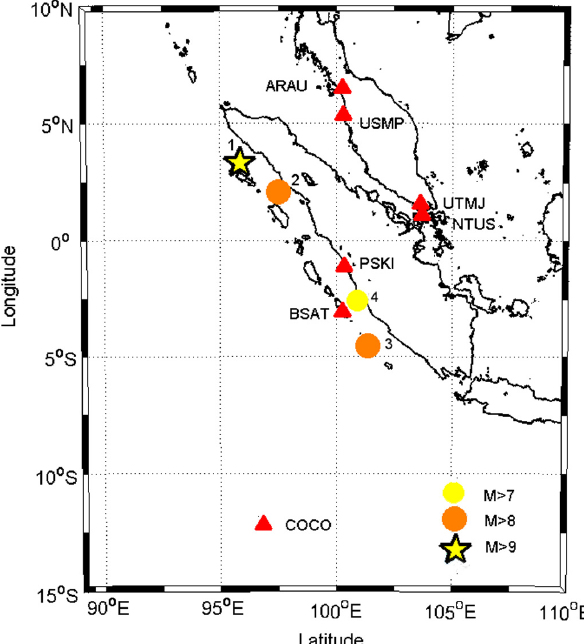
Fig. 1. Geographic locations of the four earthquake epicenters (star and circle) and GPS receiver stations